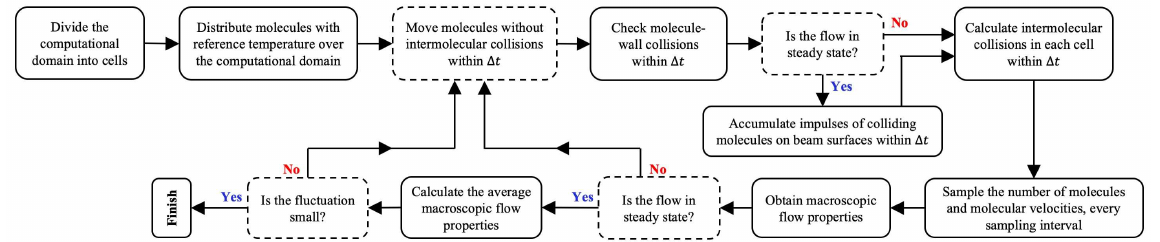
Figure 2. Flow chart of the DSMC method used in this